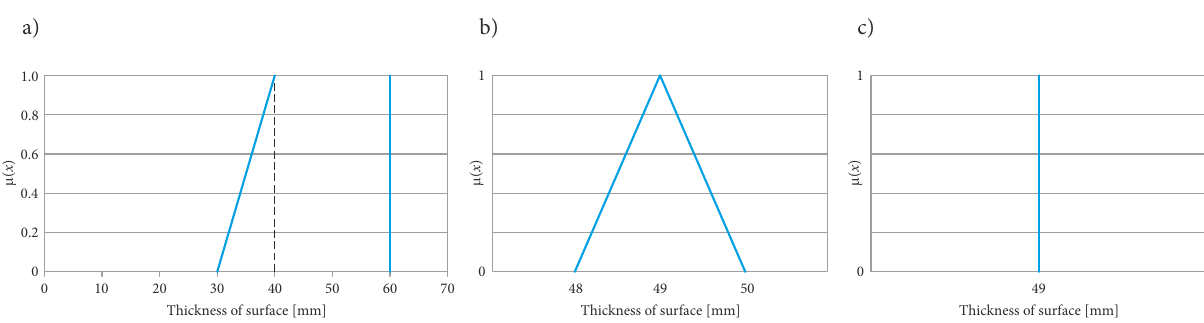
Figure 7. Membership function for the variable explaining the surfaces of football surfaces – New Case (source: own study)